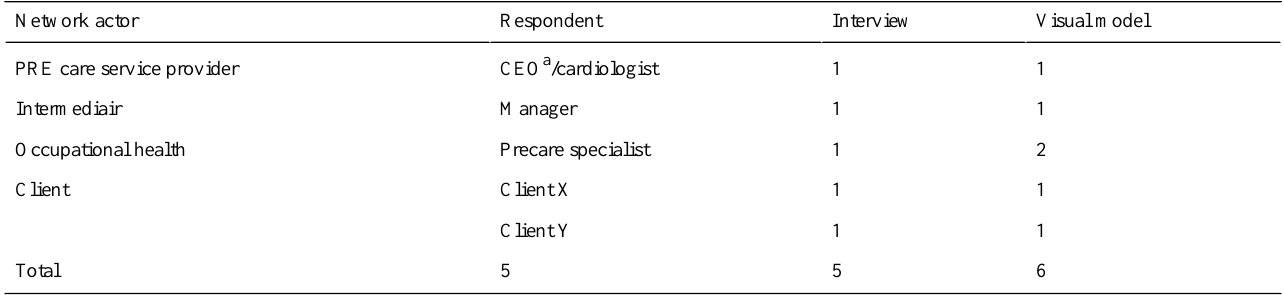
Table 2. Sample of participants in interactive